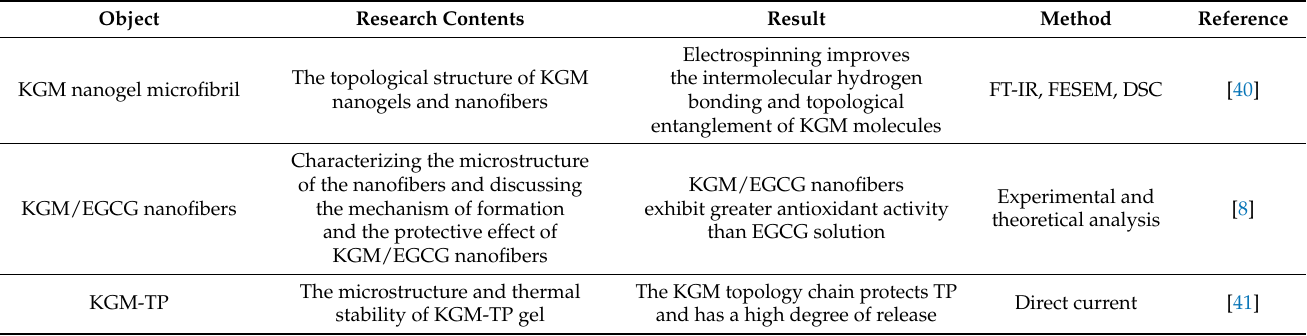
Table 3. The research progress of the KGM topological structure